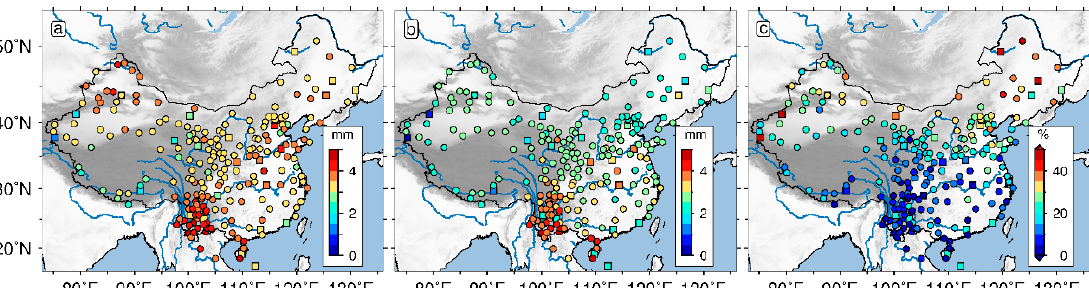
Figure 16. RMS of the CMC before ( a ) and after ( b ) environmental loading correction and the corresponding RMS reduction ratios ( c ) for the vertical displacement time series of the 231 CMONOC stations.